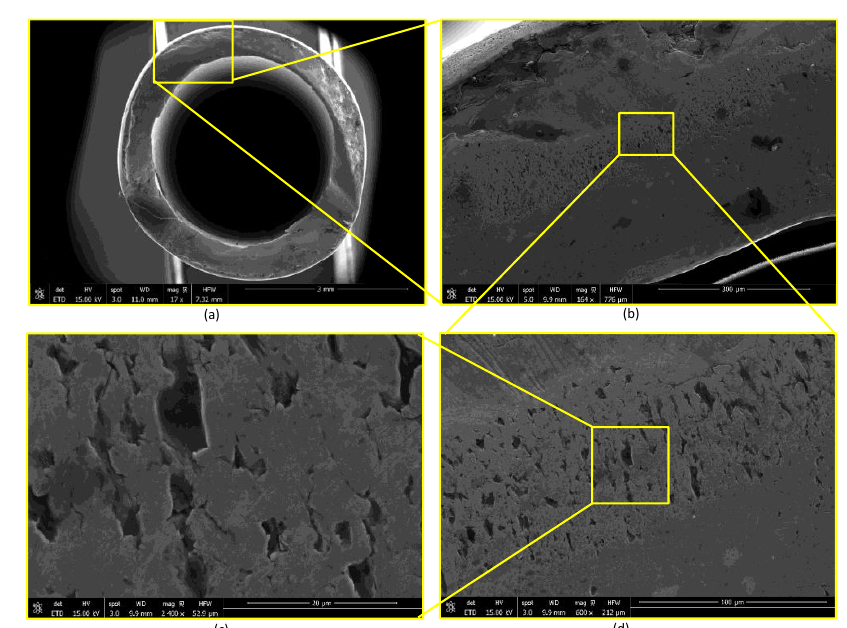
Figure A6. ( a ) Montage of SEM images showing the fracture surface of the cannulated screw, ( b – d ) dimples/overloading.